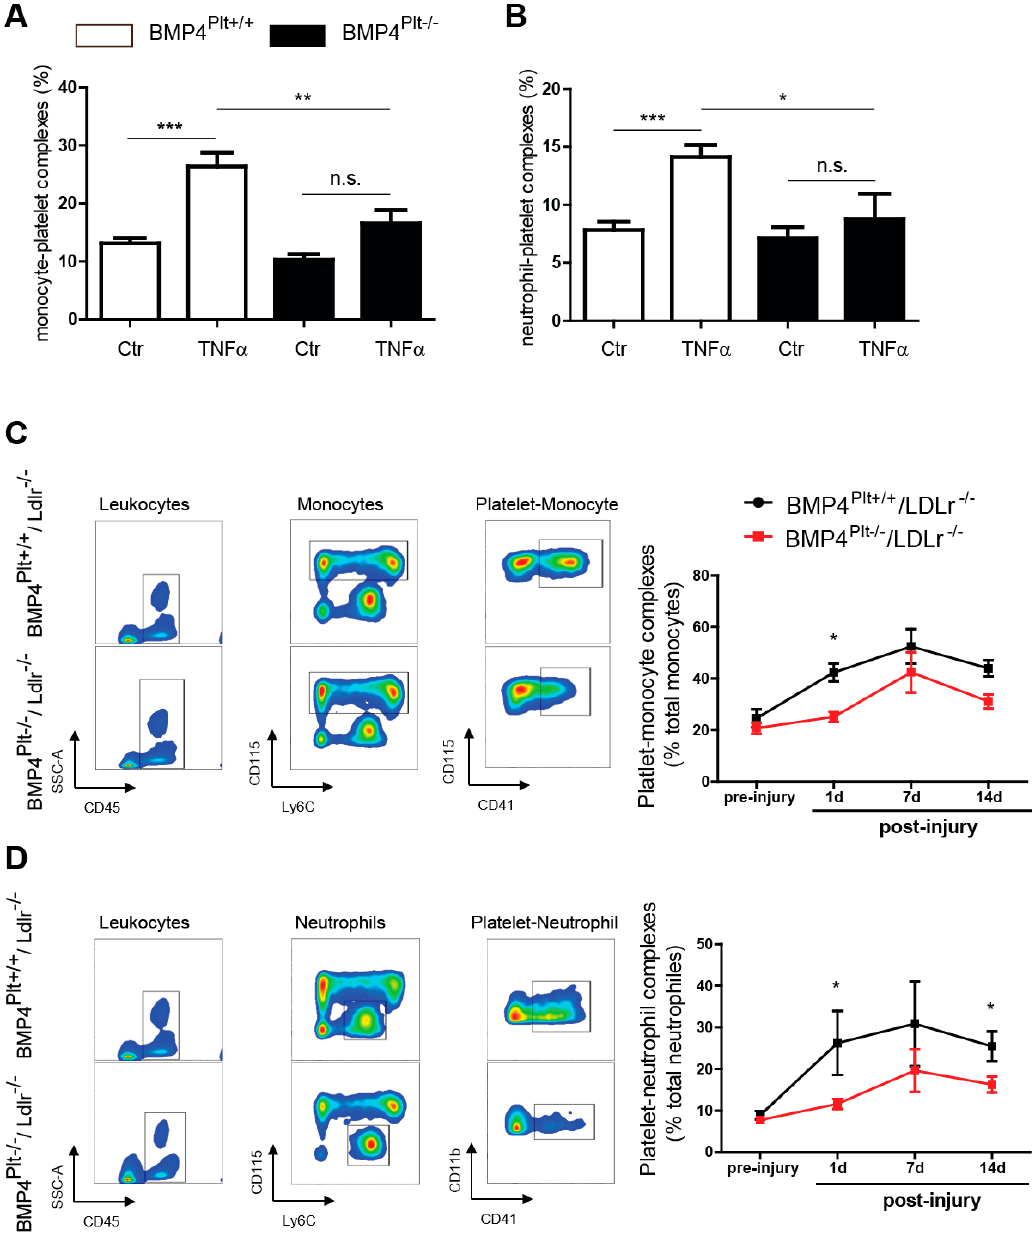
Figure 5. Platelet BMP-4 mediates platelet-leukocyte aggregation. ( A , B ) Aggregate formation of platelet-monocyte and platelet-neutrophil in control or BMP4 Plt − / − mice after stimulation with TNF α (10 ng/g body weight), n = 6 independent experiments. ( C ) Platelet-monocyte aggregate formation in control littermates or BMP4 Plt − / − /LDLr − / − mice after carotid wire injury ( n = 8 independent experiments). Monocytes were gated from CD45 + CD11b + cells. ( D ) Platelet-neutrophil aggregate formation in control littermates or BMP4 Plt − / − /LDLr − / − mice after carotid wire injury ( n = 8 independent experiments). Neutrophils were gated from CD45 + CD11b + cells. * p ≤ 0.05; ** p ≤ 0.01; *** p ≤ 0.001; n.s., not